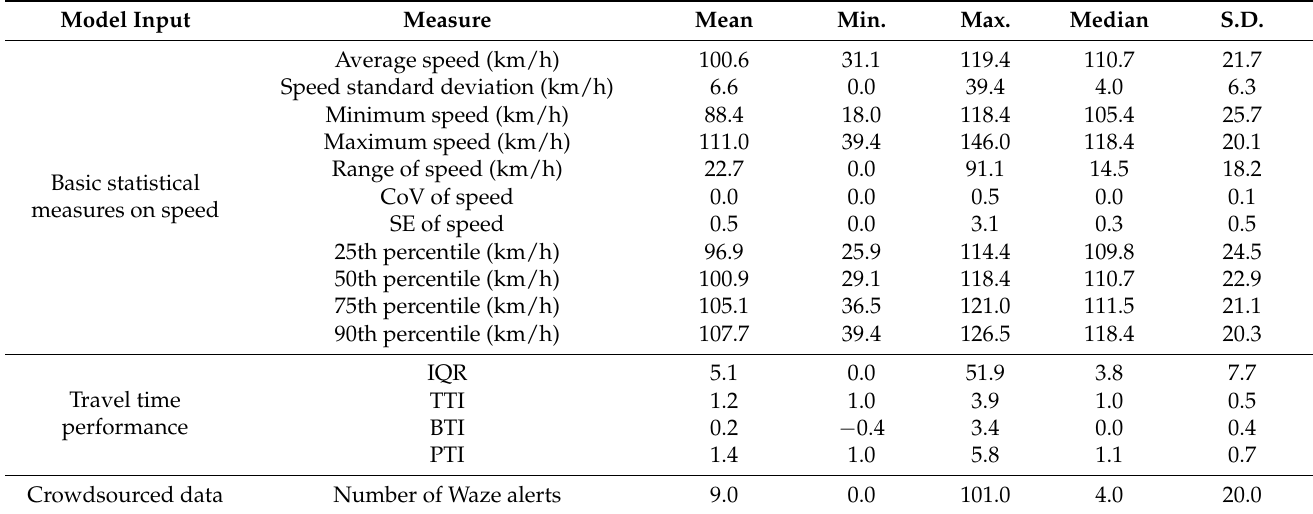
Table 5. Descriptive statistics of hourly